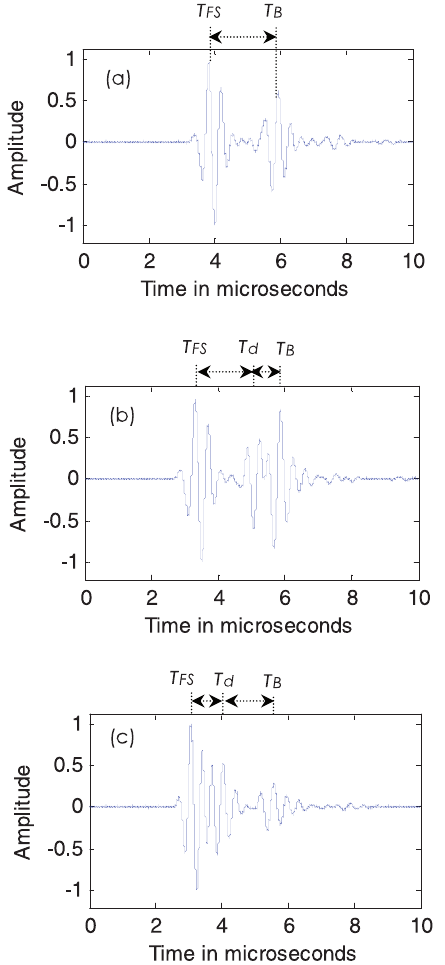
Fig. 2. (a) Waveform in undamaged region, (b, c) Waveforms in damaged region, (b) Closely echoes between delamination and back wall echo, (c) Closely echoes between delamination and front surface echo.